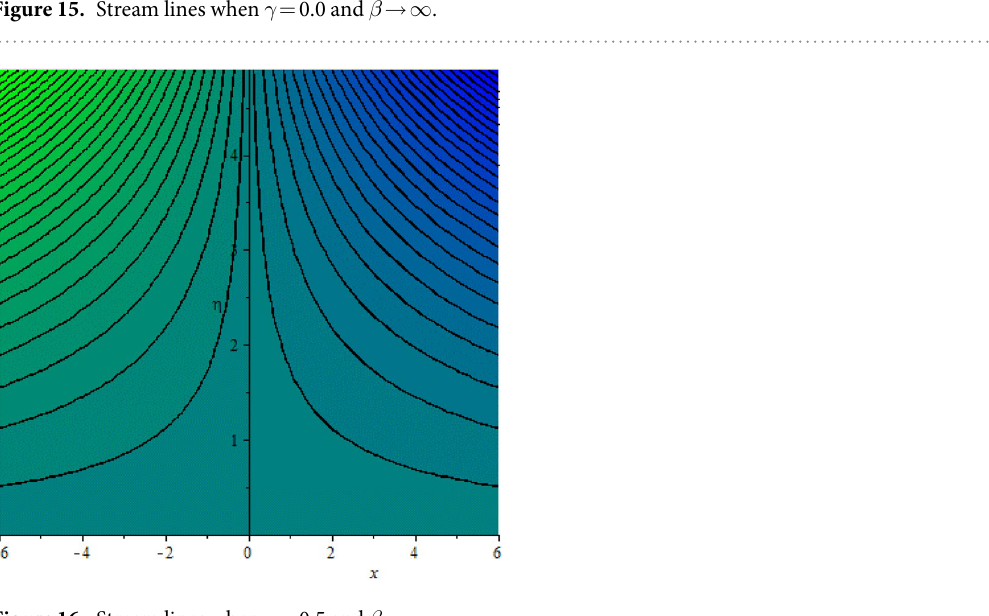
Figure 16. Stream lines when γ = 0.5 and β → ∞